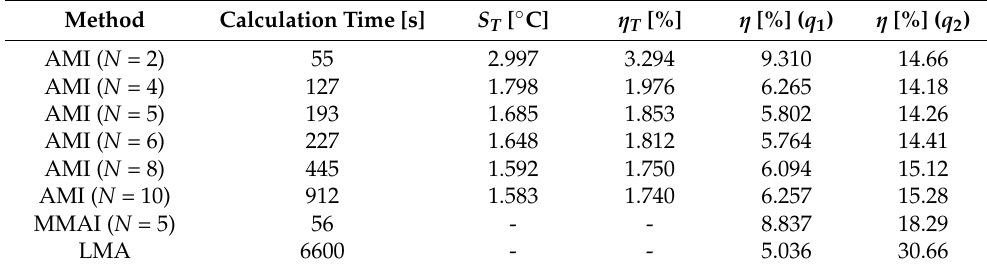
Table 2. Calculation time and obtained errors for the three methods with σ = 0.